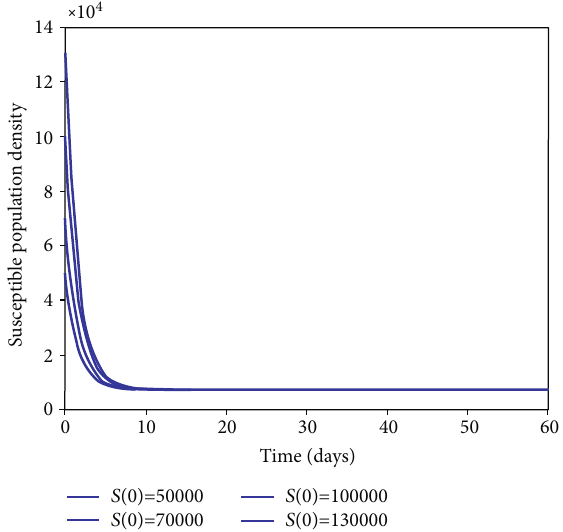
Figure 4: The time series plot of the susceptible population.